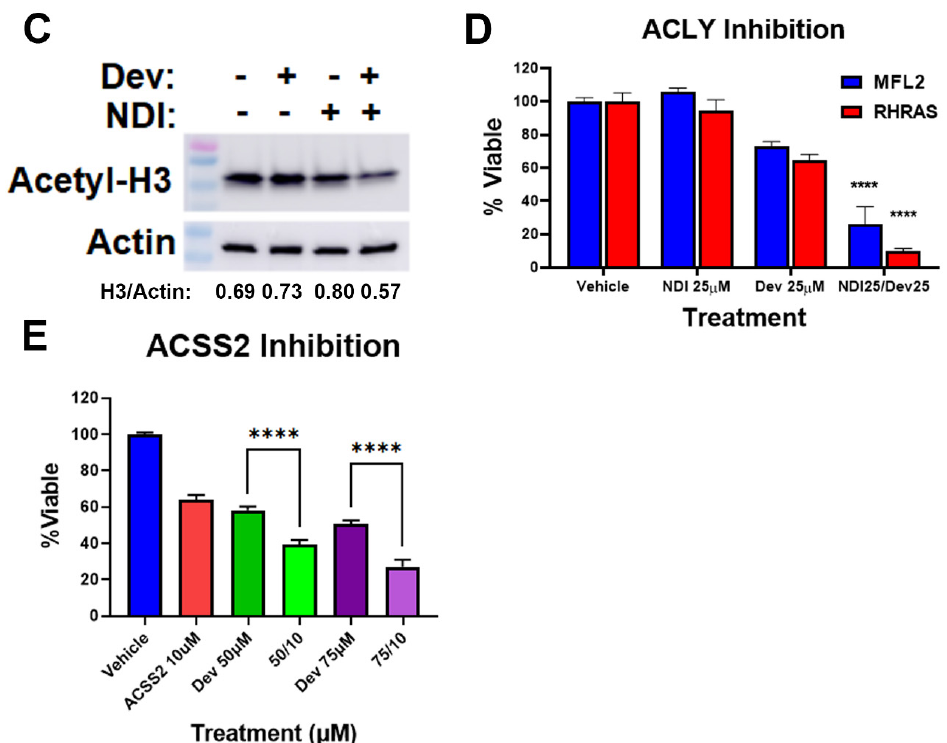
Figure 4. Devimistat alters acetyl-CoA metabolism. ( A ) MFL2 cells were treated with devimistat and etomoxir as indicated for 72 h and viability assessed. ( B ) HL60 and K562 cells were treated with the indicated amount of devimistat for 24 h and FASN activity was assessed. ( C ) MFL2 cells were treated with 100 µ M devimistat or 25 µ M of the ACLY inhibitor NDI-091143 or both for 24 h, harvested and blotted for acetyl-H3 lysine 27. Actin was used as a loading control. Relative densitometry readings below actin. ( D ) MFL2 and RHRAS cells were treated with devimistat with and without NDI-091143 for 72 h and viability was assessed. ( E ) MFL2 cells were treated as indicated for 72 h and viability was assessed. Dev = Devimistat, Eto = Etomoxir, NDI = NDI-091143, ACSS2 I = ACSS2 inhibitor, **** = p < 0.0001, * = p < 0.05. The uncropped blots are shown in File S1.